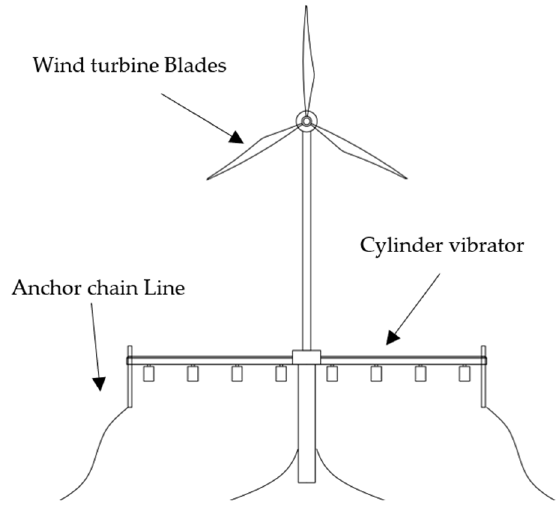
Figure 1. The Hydrodynamics of a Wind–Wave Combined Power Generation System.